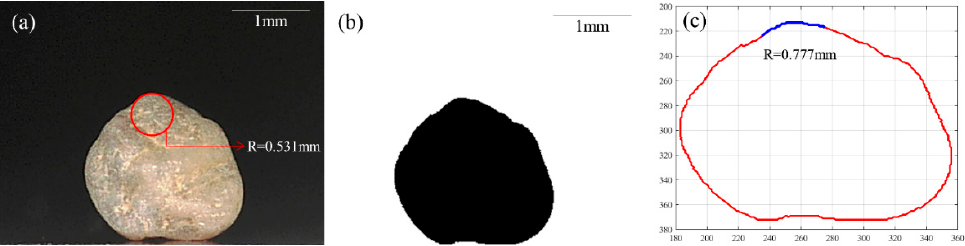
Figure 3. Example of the application of two different methods (Matlab and manual) to obtain the local radius. ( a ) Manual method from image of a grain with a circle fitted to grain boundary, ( b ) Binary image of the grain, ( c ) Pixelated boundary of the grain and the range of boundary used for local radius calculation in Matlab method.